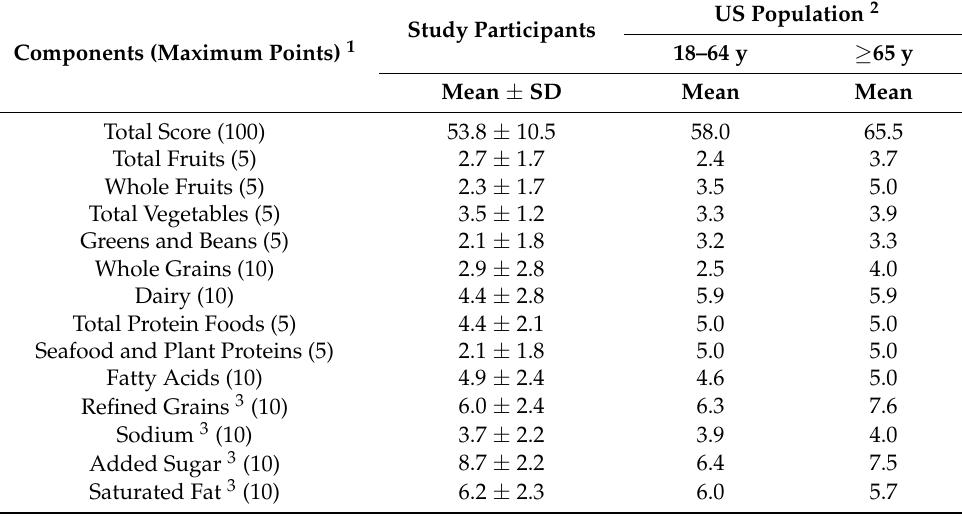
Table 4. Comparison of Healthy Eating Index 2015 scores between mobile food pantry users who completed 3-day food records ( n = 40) and the US national